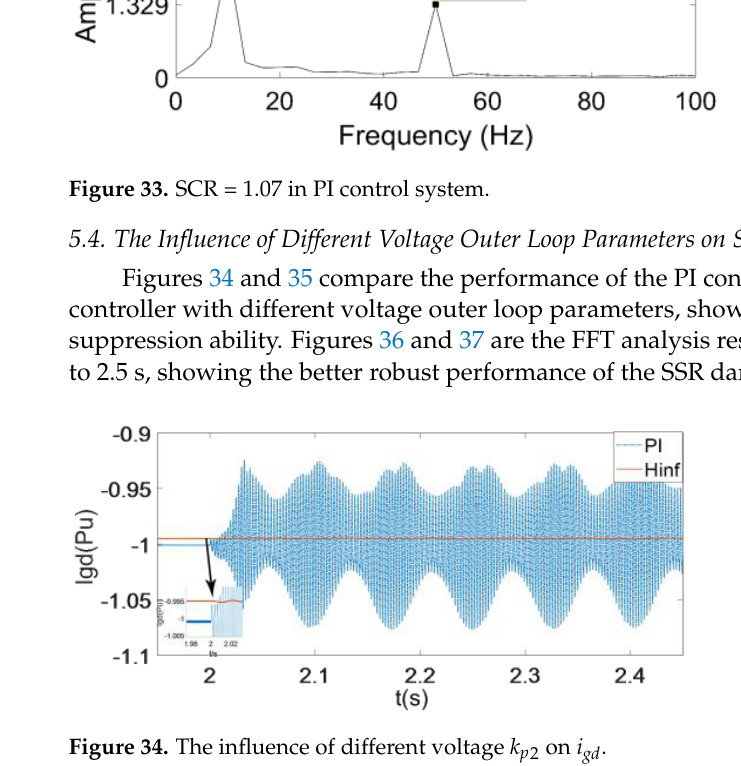
Figure 34. The influence of different voltage k p 2 on i gd.